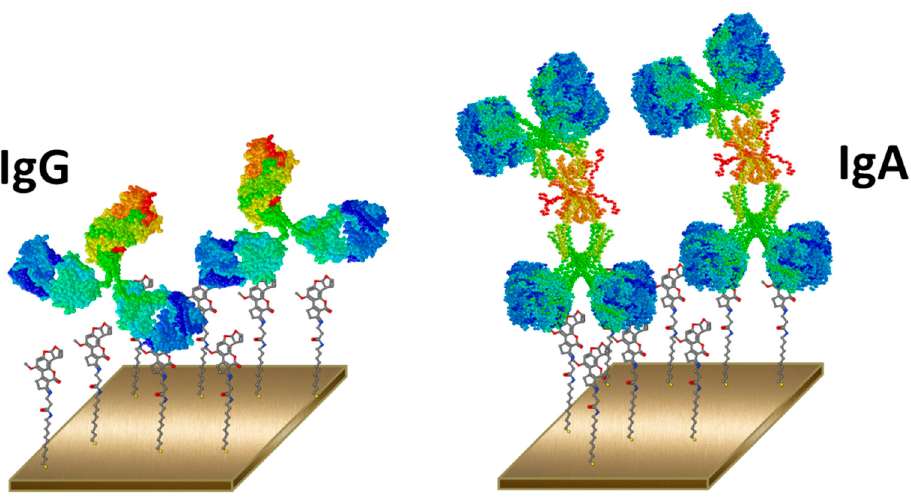
Figure 7. Use of different antibody isotypes in sensor development.